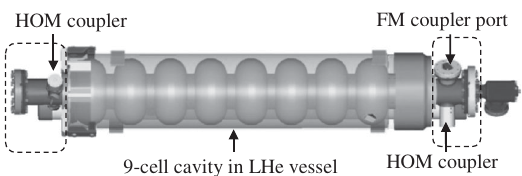
FIG. 6. Modified HOM coupler (left), magnetic field at the same stored energy for the modified coupler (mid) and current coupler